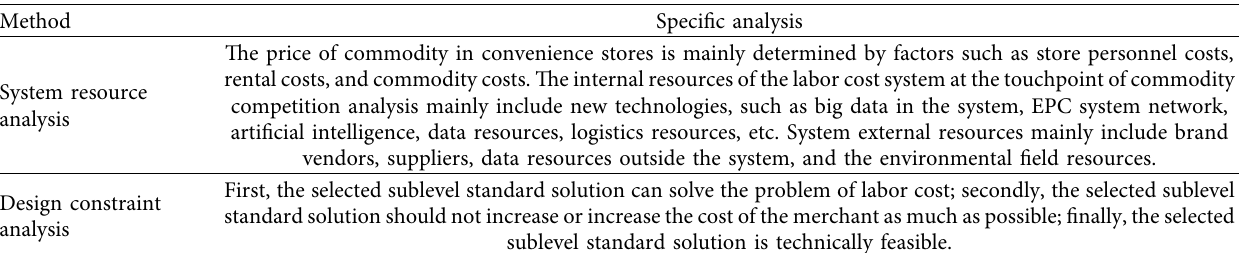
Figure 5: Model analysis of touchpoint of commodity competition analysis. Table 3: Summary of service touchpoints of convenience store